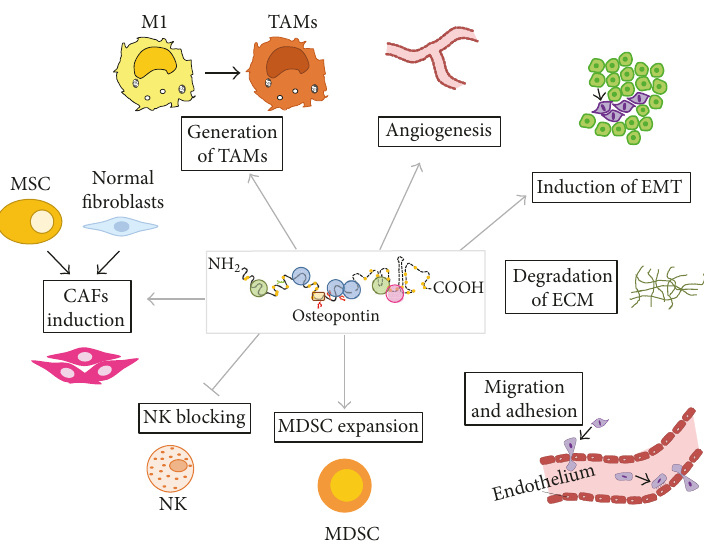
Figure 4: OPN functions in the tumor microenvironment. In the tumor microenvironment, OPN has di ff erent functions ranging from the recruitment of leucocytes, endothelial cells, and mesenchymal stem cells (MSCs) from the periphery or bone marrow, to the reprogramming of local fi broblast to cancer-associated fi broblasts and transformation of M1 antitumorigenic macrophages to tumor-associated macrophages. These changes in the stroma favor tumor progression through angiogenesis, degradation of the extracellular matrix, epithelial to mesenchymal transition (EMT), and migration of metastatic